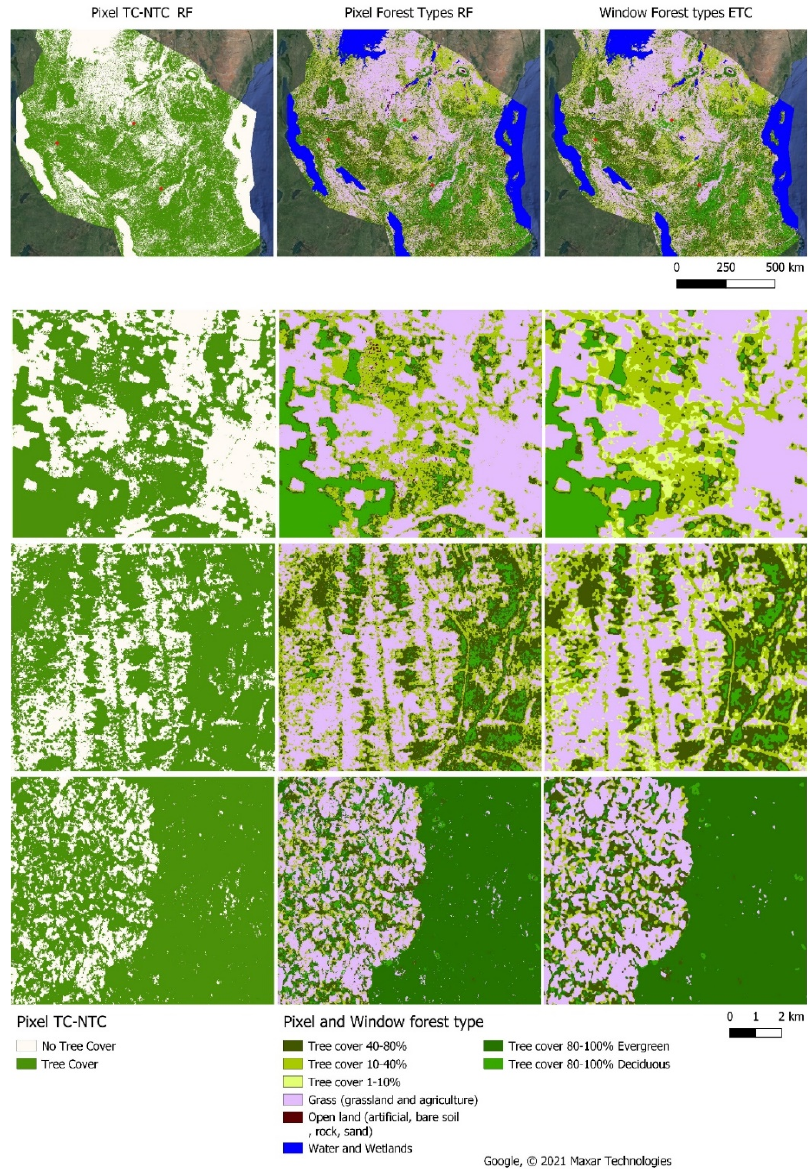
Figure 9. Resulting maps from the three classification workflows.